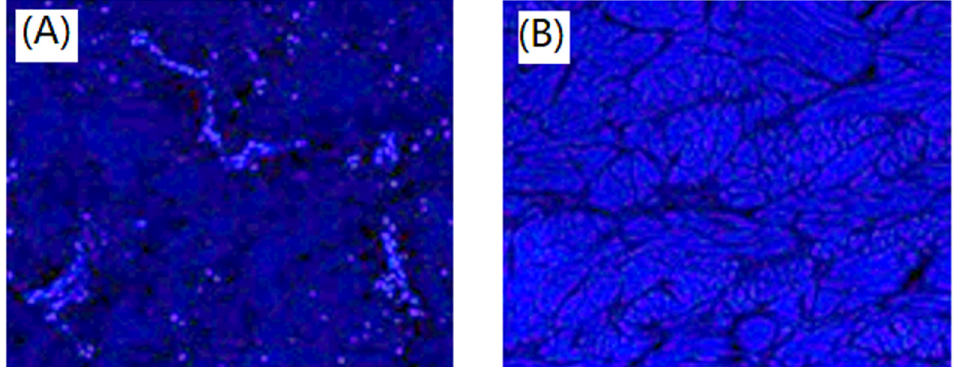
Figure 5. DAPI staining of unaffected porcine dermal ( A ) and porcine dermal segments after decellularization ( B ). Magnification 100×.